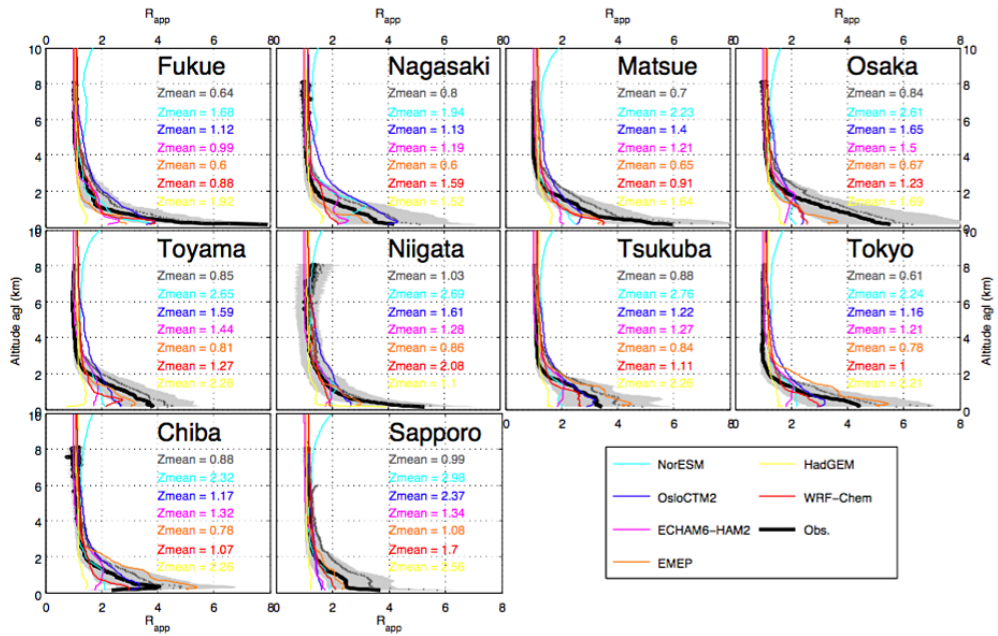
Figure 11. Comparison of mean (grey dots), median (black line), the 25th and 75th percentiles (grey area) of R app profiles observed at 10 NIES aerosol lidar stations over Japan (location shown in Fig. 1) and mean R app (coloured lines) simulated by the ECLIPSE